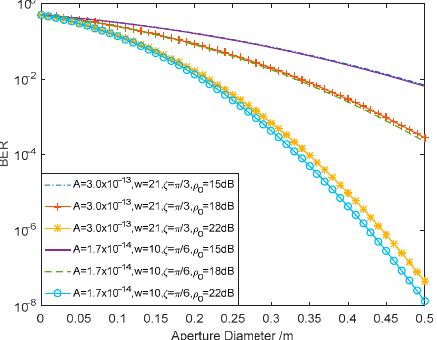
Figure 1. Performance of bit error rate (BER) when the aperture area is variable.